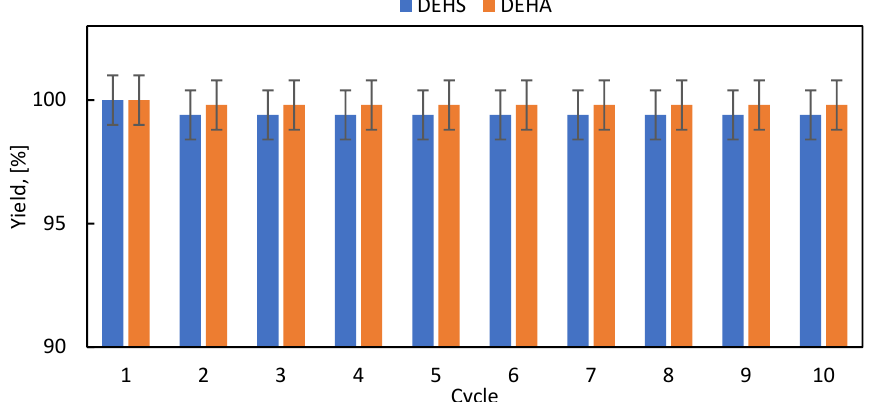
Figure 5. Recycle studies. Reaction conditions: IL 2.7 (15 mol%/mol succinic acid (0.0025 mol)); alcohol 4 mol; acid 1 mol; 80 ◦ C (DEHS); 80 ◦ C (DEHA), 17 Hz; reaction time 240 min. After each cycle, the post reaction two-phase mixture was separated, the lower phase (mainly containing IL) was dried on the rotary evaporator and used for the next cycle. The upper layer containing ester was dissolved in acetonitrile and analysed using GC-FID. GC samples were analysed in triplicate and the errors were calculated as standard deviations.